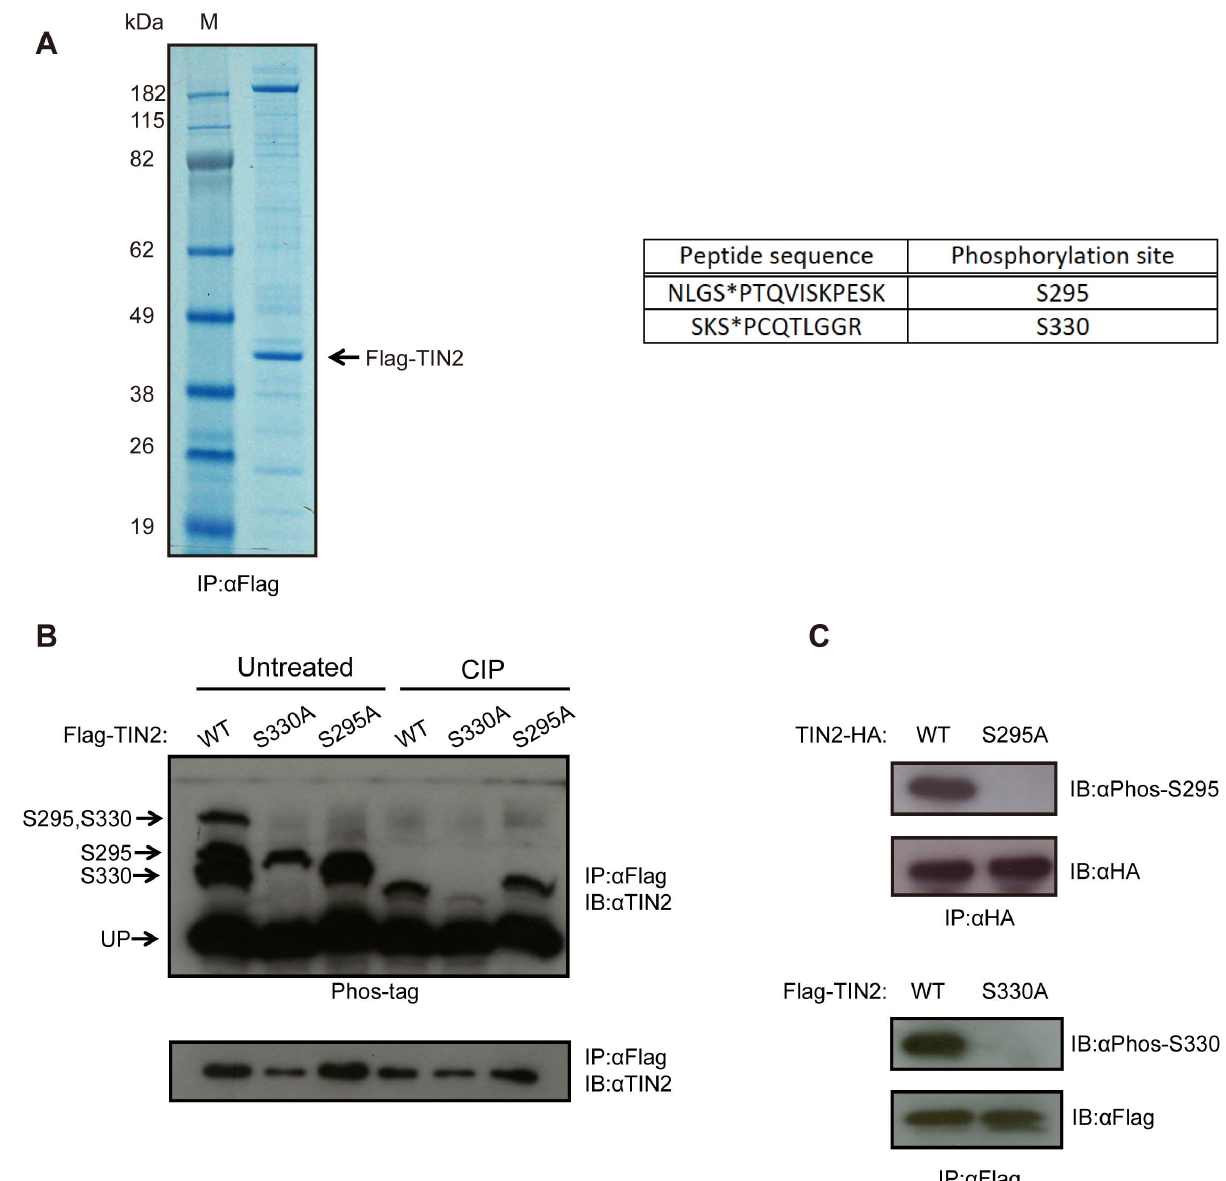
Figure 1. TIN2 is phosphorylated on Serine 295 and Serine 330. ( A ) Identification of phosphorylation sites on TIN2 by mass spectrometry. Left, A lysate from HeLa cells stably infected with a retrovirus encoding N-terminal Flag epitope-tagged TIN2 (Flag-TIN2) was subjected to immunoprecipitation (IP) with an anti-Flag antibody, resolved by SDS-PAGE, and detected by Coomassie Brilliant Blue staining. M: marker lane. Right, The purified protein was then recovered and digested by trypsin, followed by TiO2 enrichment and mass spectrometry analysis, revealing two peptides with phosphorylated serine residues (denoted with an *). Representative of one experiment. ( B ) Detection of phosphorylation of TIN2 at S295 and S330 by the Phos-tag reagent. Lysates from HeLa cells stably infected with a retrovirus encoding Flag-TIN2 in the wild-type (WT), S330A, or S295A configuration were subjected to immunoprecipitation (IP) with an anti-Flag antibody and then either left untreated or treated with calf intestine phosphatase (CIP), followed by SDS-PAGE either in the presence ( top ) or the absence ( bottom ) of the Phos-tag reagent and immunoblotted (IB) with an anti-TIN2 antibody. The supershifted bands corresponding to S295, S330, or S295 and S330 phosphorylation, as well as the unphosphorylated TIN2 (UP), are denoted on the left. Representative of three experiments. ( C ) Detection of S295 and S330 phosphorylation of TIN2 with phosphorylation-specific antibodies. Lysates from HeLa cells stably infected with a retrovirus encoding C-terminal HA epitope-tagged TIN2 (TIN2-HA) or Flag-TIN2 in WT, S295A, or S330A configuration were subjected to immunoprecipitation (IP) with either an anti-HA or anti-Flag antibody, resolved by SDS-PAGE, and immunoblotted (IB) with either an anti-Phos-S295 or anti-Phos-S330 antibody to detected the phosphorylated TIN2, and either an anti-HA or anti-Flag antibody to detect total ectopic TIN2 as a loading control. Representative of two experiments. doi:10.1371/journal.pone.0071697.g001 stably expressed in HeLa cells. All three proteins were immuno- can specifically bind to phospho groups on proteins and impede precipitated by virtue of the Flag tag and resolved by SDS-PAGE their migration [20]. TIN2 was then detected by immunoblot with containing the dinuclear metal complex Phos-tag reagent, which an anti-TIN2 antibody. This analysis revealed four major bands